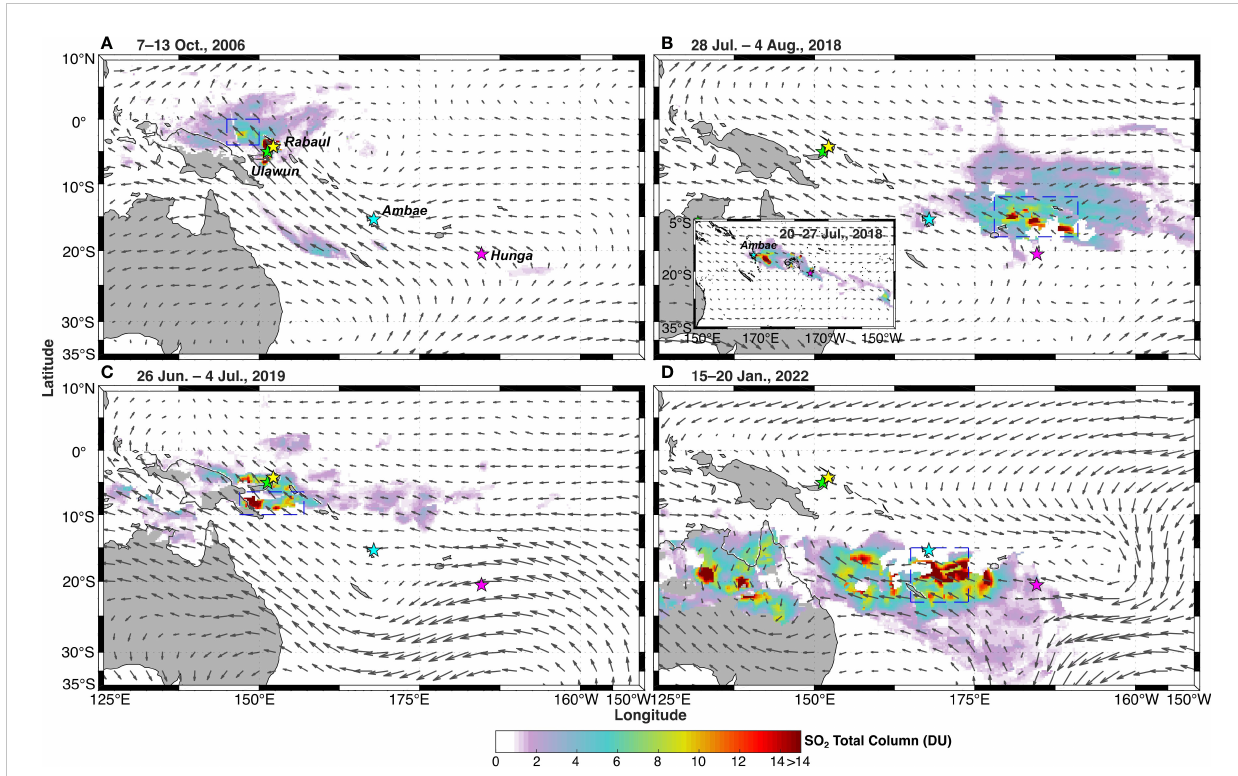
FIGURE 2 A spatial distribution of the SO 2 total column averaged over the period of (A) 7-13 October, 2006, (B) 28 July - 4 August, 2018, (C) 26 June - 4 July, 2019, and (D) 15-20 January, 2022, with surface wind (at 925 hPa). Inserted fi gure in (B) is the spatial distribution of SO 2 total column averaged over the period of 20-27 July,